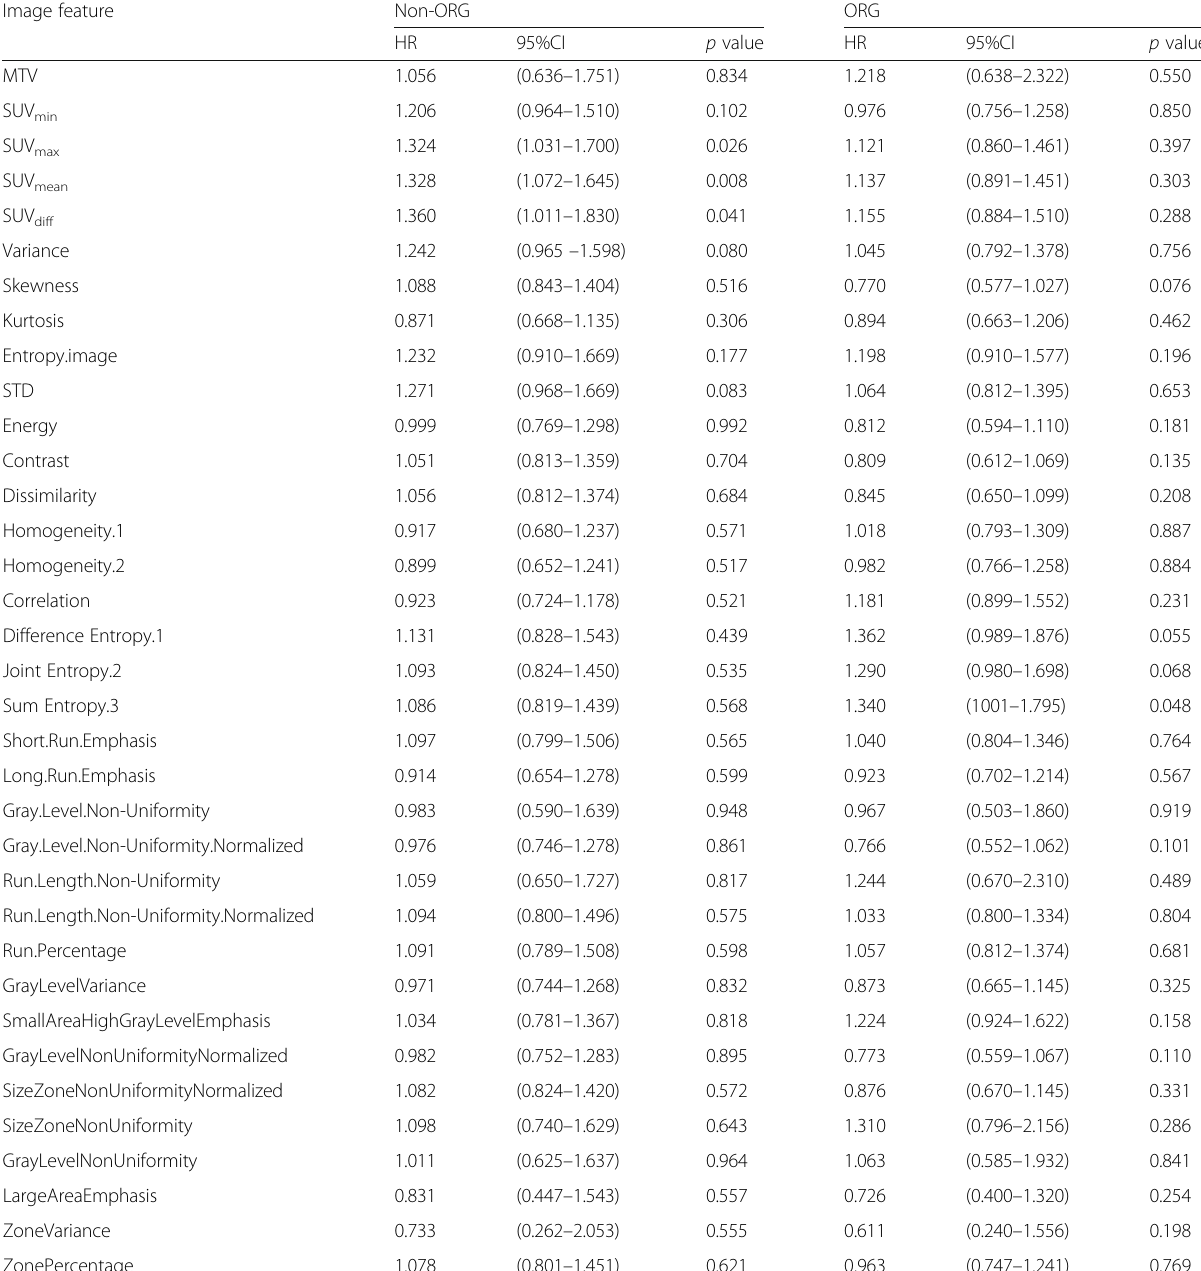
Table 2 Optimal respiratory gating impacts the correlation of [ 18 F]FDG PET-derived image features with overall survival, assessed by univariate logistic regression